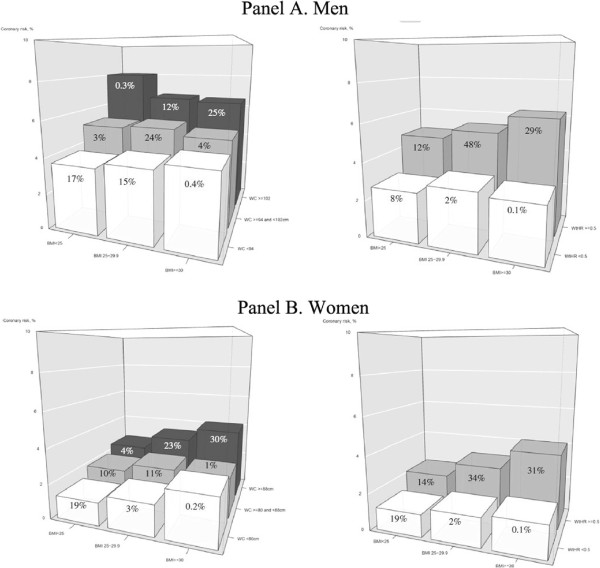
Coronary risk according to body mass index and waist circumference (left) and waist-to-height ratio (right) categories in men (Panel A) and in women (Panel B).